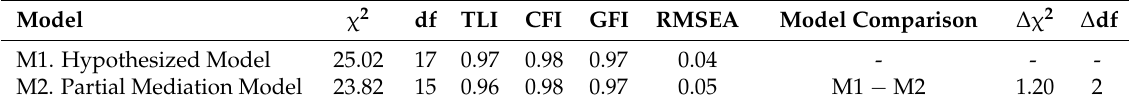
Table 2. Goodness-of-Fit indices of the nested models and tests of indirect relationships ( N =